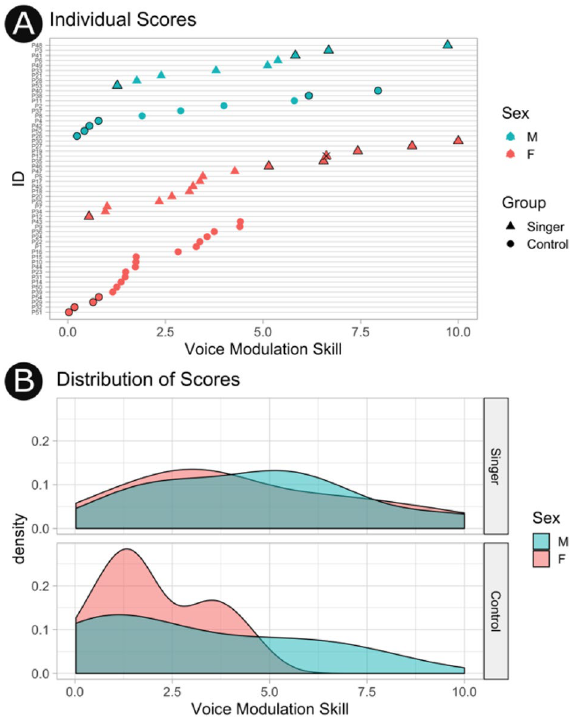
Figure 3. Vocal tract modulation skill. ( A ) Individual vocal tract modulation skill scores (calculated as the difference in median fPC2 scores while imitating larger vs. smaller sounding vocal targets) are plotted for each participant grouped by vocal training and sex and ranked within those groupings. The five highest and lowest ranked speakers are marked by black outlines and compose the good and poor vocal tract modulation skill groups. One participant marked with an x did not consent to their recordings being played to third parties for subsequent experiments and was therefore excluded. ( B ) The distributions of vocal tract modulation skill scores demonstrating an overall advantage for singers despite considerable variation within both